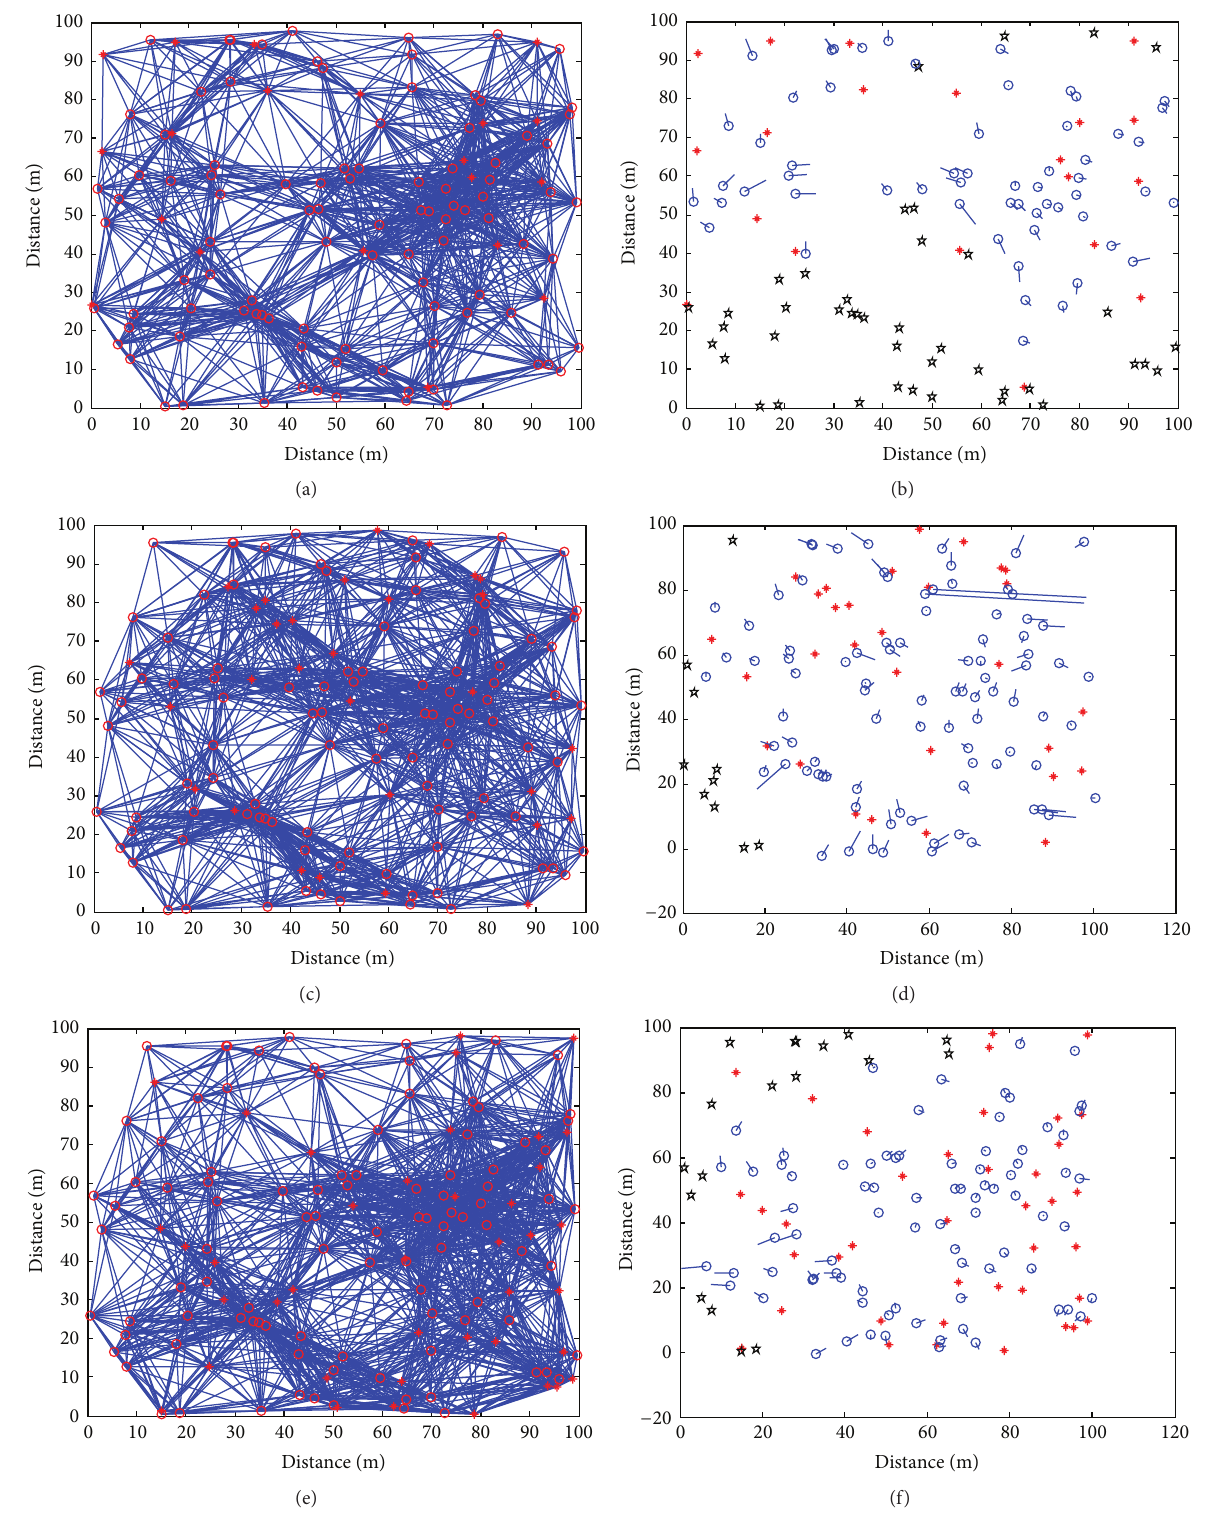
Figure 4: Connectivity and localization effect ((a), (c), and (e) are the neighbor relationship of nodes for the beacon node’s number of 20, 30, and 40, resp. (b), (d), and (f) are the localization error for the beacon node’s number of 20, 30, and 40, resp. The communication radius is always 30